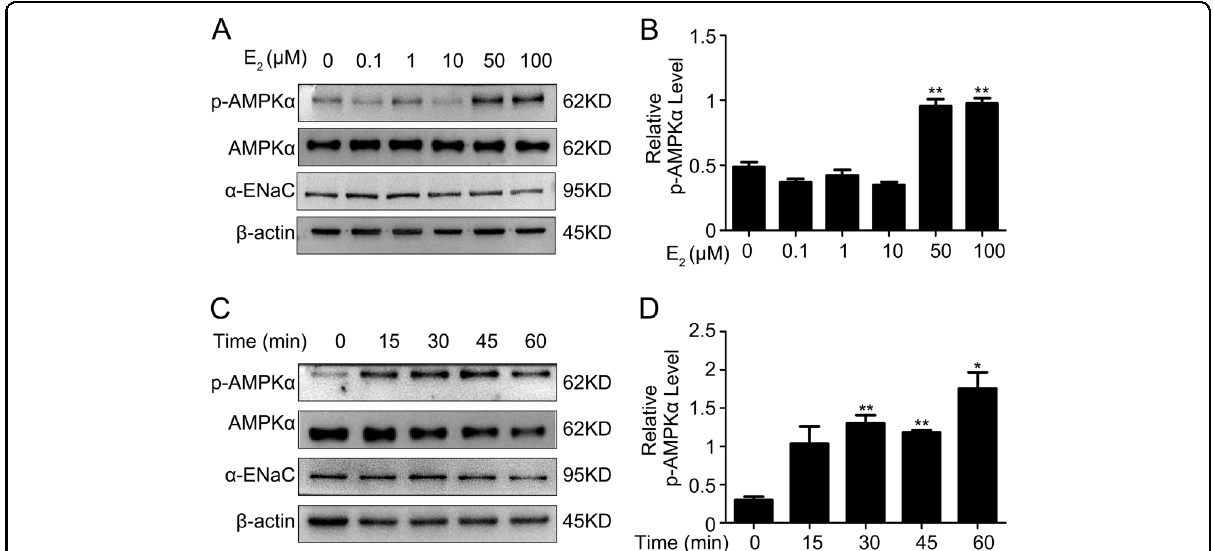
Fig. 8 Estrogen evokes phosphorylation of AMPK in mpkCCDc14 cells. a The expression levels of phosphorylated AMPK and total AMPK in mpkCCDc14 cells stimulated with a series of E 2 concentrations were determined by western blot analysis. b Quanti fi cation of the phosphorylated AMPK expression shown in ( a ) normalized to β -actin expression. c The expression levels of phosphorylated AMPK and total AMPK in mpkCCDc14 cells during a time course of E 2 stimulation were determined by western blot analysis. d Quanti fi cation of the phosphorylated AMPK expression shown in c normalized to β -actin expression. The bars are the means ± SE values from three independent experiments. * P < 0.05 and **P < 0.01 compared to the Con group